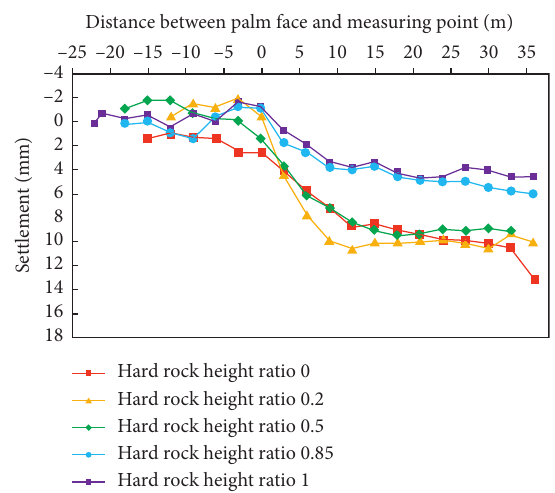
Figure 8: Longitudinal surface subsidence curves of different hard rock height